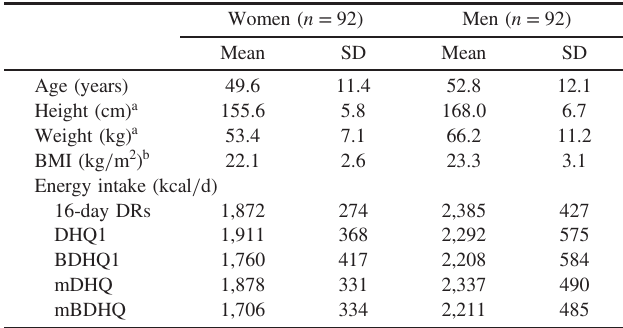
Table 2. Basic characteristic of Japanese women and men Women ( n = 92)